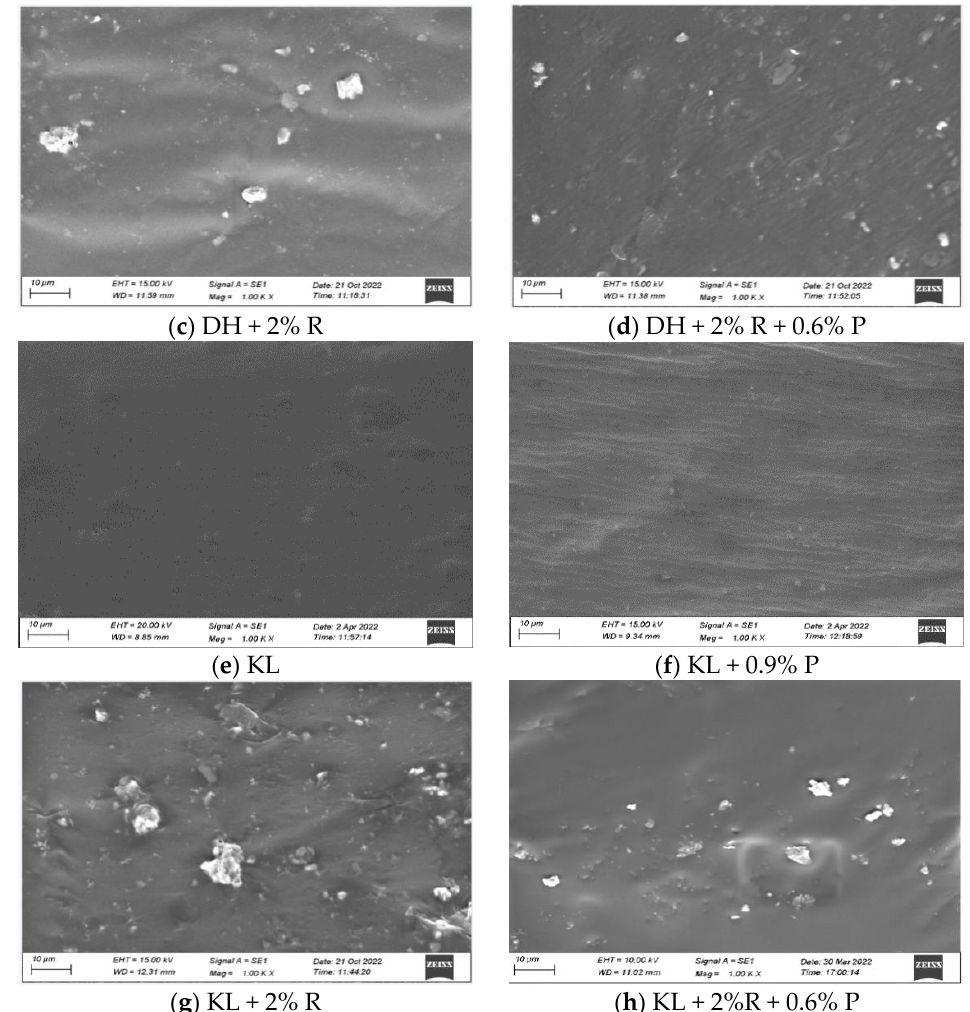
Figure 3. Scanning electron microscopy results of asphalt at 1000